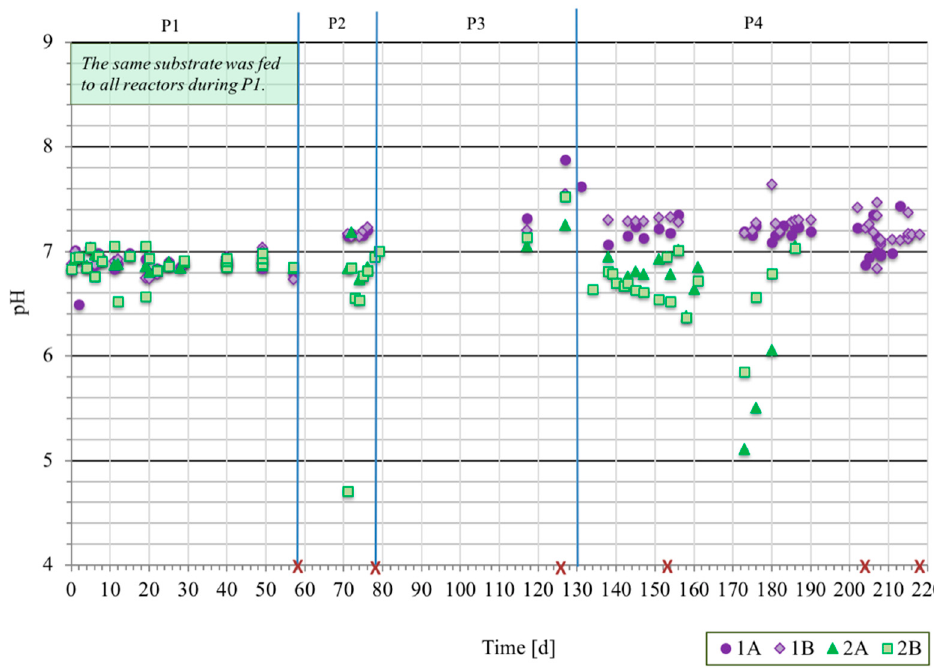
Figure 2. Values of pH recorded in liquids of upflow anaerobic sludge (UASB) reactors 1A, 1B, 2A, and 2B. Time points of microbial sampling are marked with red crosses. The blue lines indicate the changes between operating periods 1 to 4 (P1–P4) described in Table 1. Abbreviations: d—days.